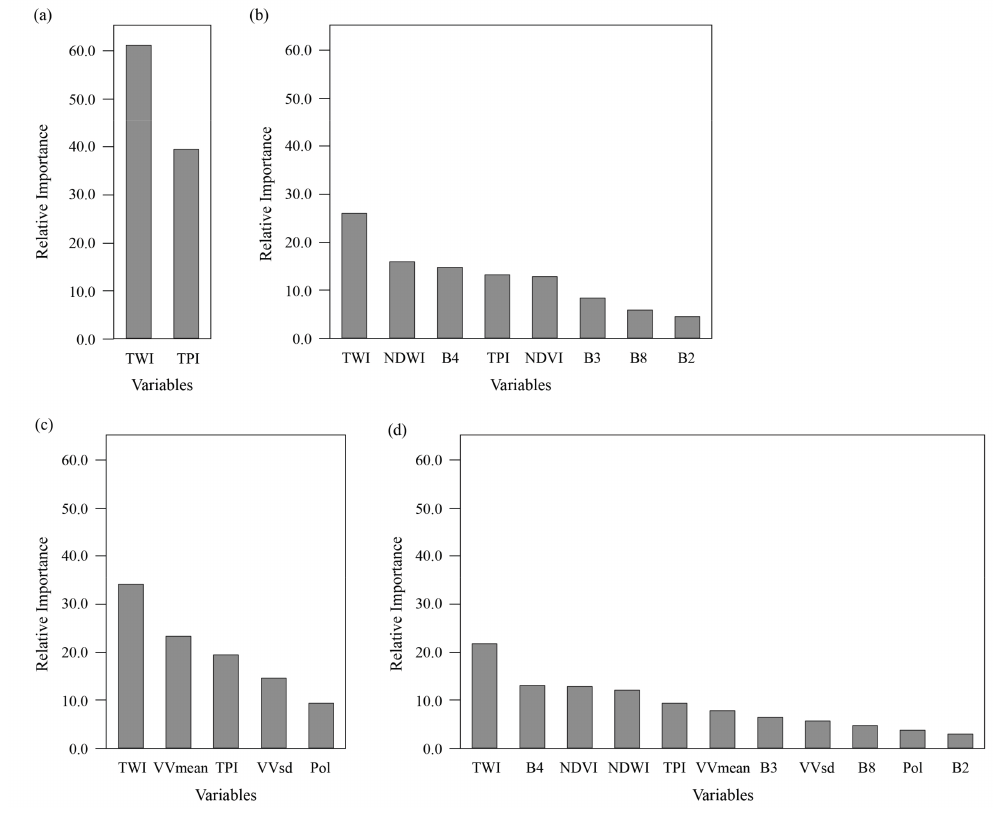
Figure 3. Relative variable importance for the four wetland probability models: ( a ) T model , ( b ) TO model , ( c ) TS model , and ( d ) TOS model , averaged over all 50 iterations for each